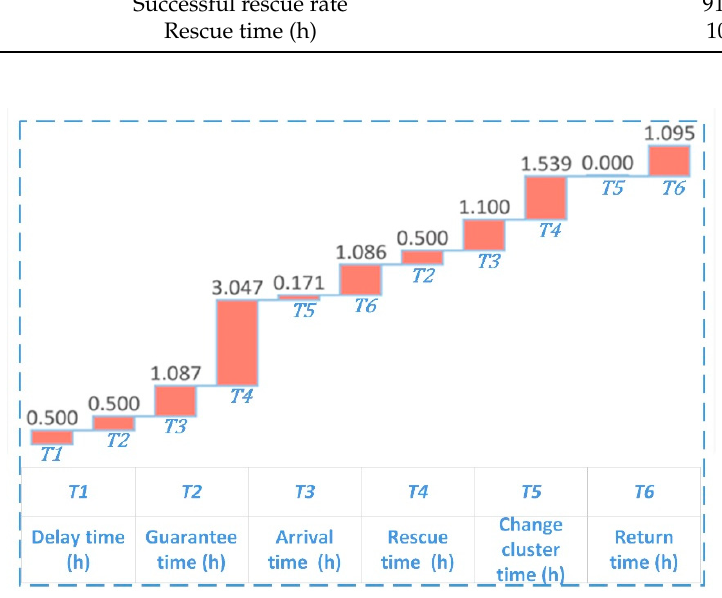
Figure 13. Rescue time of each stage for the TPM-0.5 with 45 PDTs.